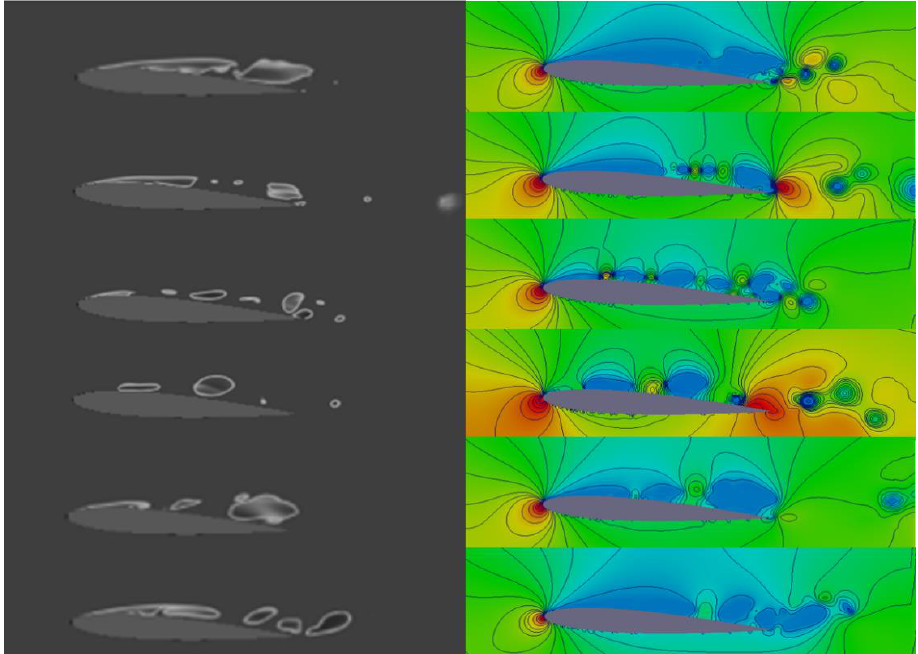
Figure 9. Evolution of the periodic sheet/cloud cavitating flow (contours of vapor fraction and pressure coefficient).